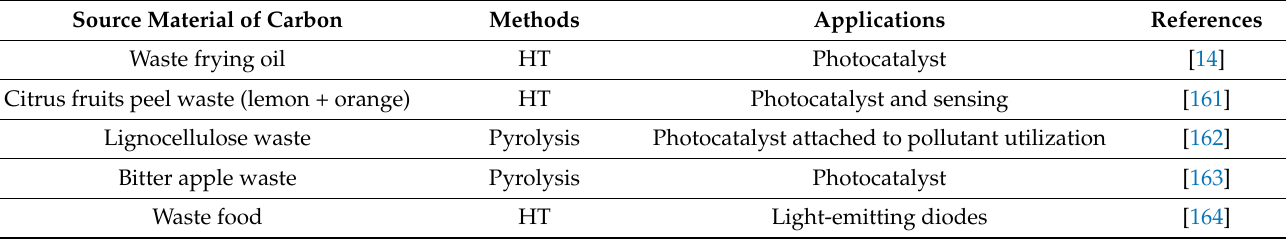
Table 13. Applications of C-dots in catalysis, optronics and